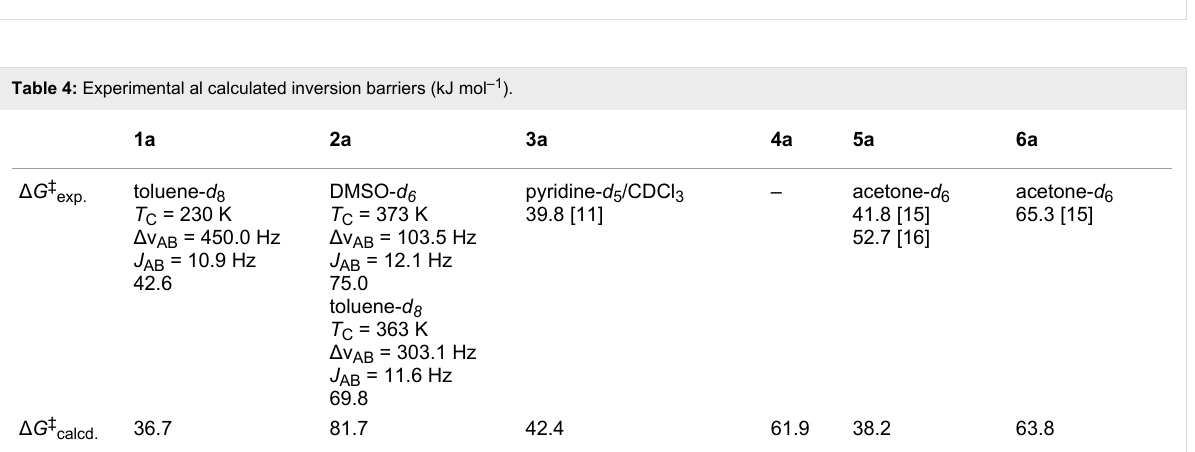
Table 4 we have determined the corresponding experimental inversion barriers. The agreement between experimental and calculated values is satisfactory: using for 2a the 75.0 kJ mol − 1 and for 5a